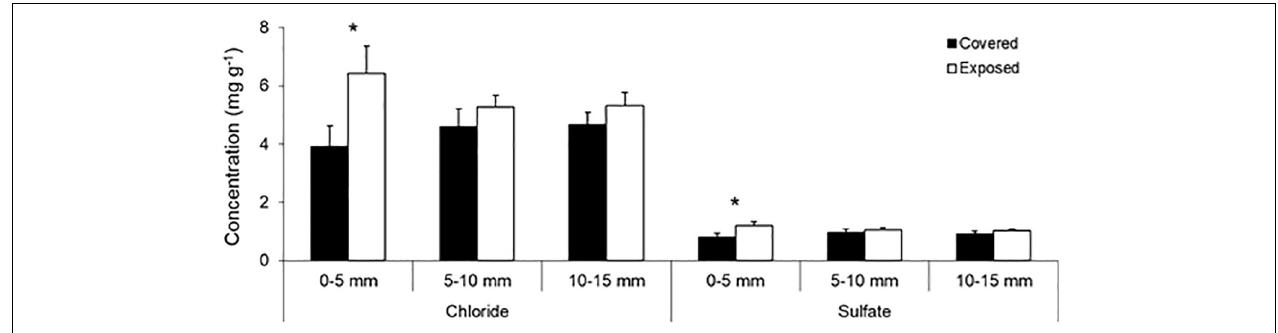
FIGURE 4 | Subsurface salt content of the mussel-covered and mussel-removal (exposed) bench substrates at three depth ranges. Substrate samples were collected on a clear and exceptionally hot late-spring day (November 21, 2018) 2.5–3 h after the tide had receded and the platform was air-exposed. The vertical lines above the bars indicate 1 SD. Asterisks indicate significant treatment effects at the corresponding depth level ( p < 0.05).